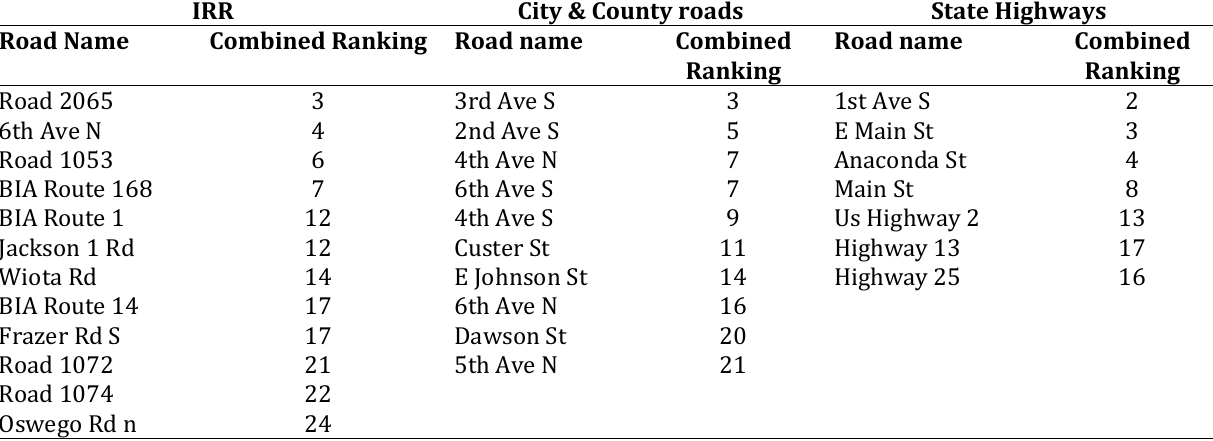
Table 3: Combined ranking on three roadway systems